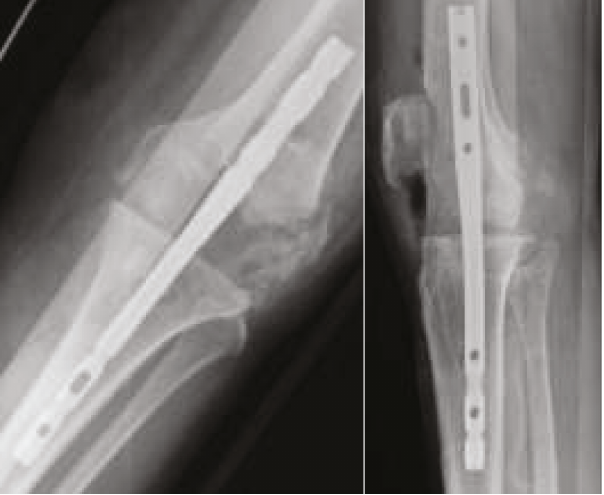
Figure 3: Intraoperative periprosthetic fracture fi xated with an intramedullary